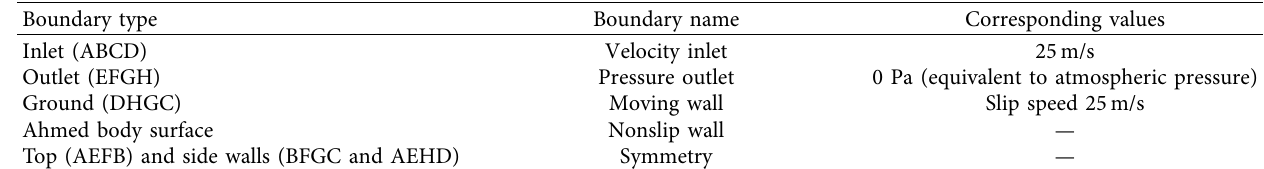
Table 3: Setup of boundary conditions.